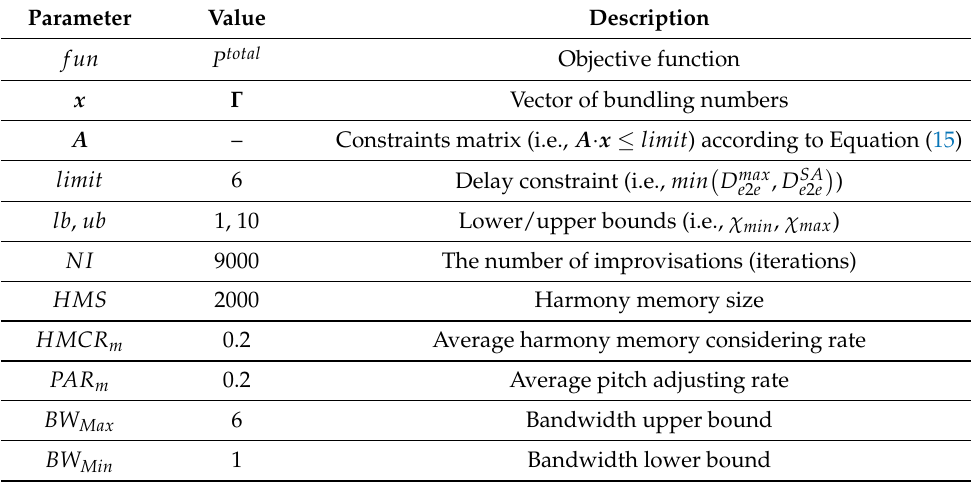
Table 4. Parameter settings of SGHS for optimal